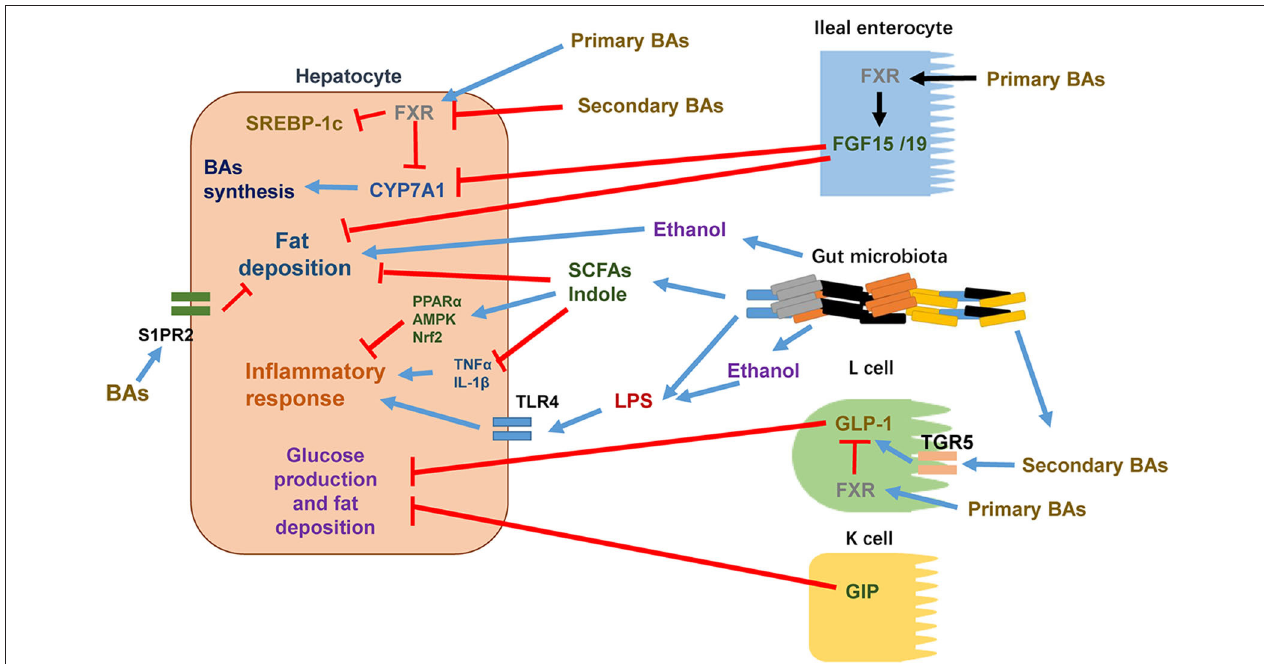
FIGURE 1 | The crosstalk between intestine and liver in the pathophysiology of NAFLD. Certain intestine hormones, e.g., GLP-1 and GIP, reduce hepatic glucose production and fat accumulation. In L cells, secondary BAs stimulate GLP-1 synthesis and release via TGR5 activation whereas primary BAs activate FXR to inhibit GLP-1 synthesis and release. Other intestine hormones, e.g., FGF15 and FGF19, decrease hepatic lipogenesis. BAs stimulate FXR in ileal enterocytes, leading to the release of FGF15/19 into circulation. After reaching to hepatocytes, FGF15/19 suppresses BA synthesis through inhibiting CYP7A1 expression. Increased gut permeability, altered composition of gut microbiota, and elevated levels of gut microbiota metabolites such as ethanol are shown to enhance hepatocyte fat deposition and increase the flow of LPS into the circulation to promote proinflammatory responses through activating TLR4 signaling pathway in target cells. In hepatocytes, certain primary BAs acts through activating FXR to suppress the activity of SREBP-1c and thus reduces the expressions of lipogenic genes. Primary BAs also inhibit CYP7A1 expression and thus reduces BAs synthesis. Certain secondary BAs inhibit the activation of hepatic FXR. In addition to activation of FXR, BAs are shown to regulate hepatic lipid and sterol metabolism through activating S1PR2. Certain gut microbiota metabolites such as SCFAs and indole reduce hepatocyte fat deposition and proinflammatory responses via decreasing TNF α and IL-1 β and/or activating PPAR α , AMPK, and